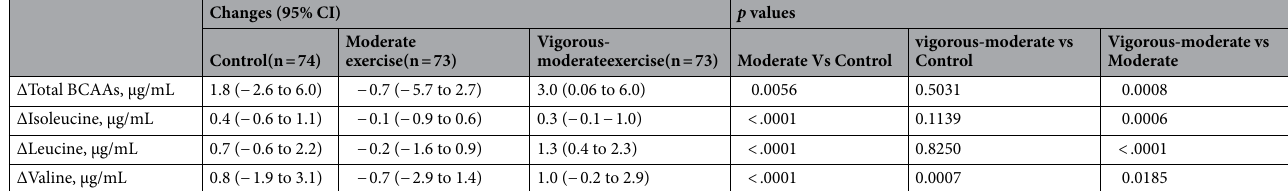
Table 6. Effects of moderate and vigorous exercise on plasma concentration of BCAAs ( P < .008 (0.05/6 comparisons) ) was considered statistically significant.